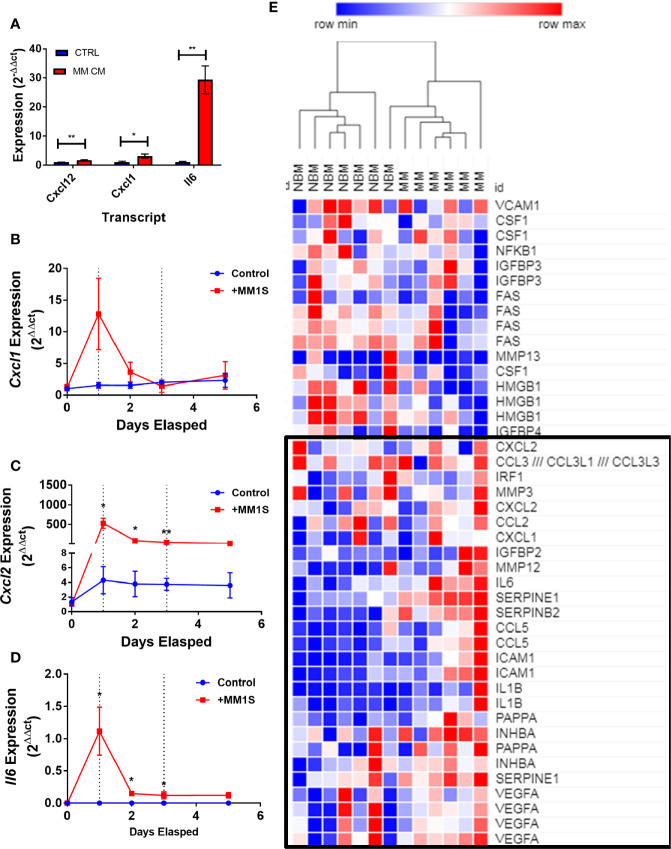
Exposure to myeloma cells prior to adipogenic differentiation induces SASP production in adipocyte precursors. 3T3-L1 cells exposed to MM.1S soluble factors during differentiation exhibit increased expression of: Il6, Cxcl1, and Cxcl12 after terminal differentiation (A). Mouse bone marrow MSCs were exposed to MM.1S cells in vitro for up to 72 h prior to adipogenic differentiation. Cells were harvested for RNA extraction after 24 (first dotted line), 48, and 72 (second dotted line; change to adipogenic media) hours of pre-exposure, and after the first treatment of adipogenic media (day 5). Cxcl1
(B), Cxcl2
(C), and Il6
(D) gene expression was quantified in mMSCs at each time point; n=3 per group, *p < 0.05, **p < 0.01. Reanalysis of previously published MSC gene expression data comparing bone marrow from normal donors (NBM) and myeloma donors (MM) examining the SASP gene cluster (E) data from Corre et al. 2007, Leukemia.; heatmap generated via Morpheus.